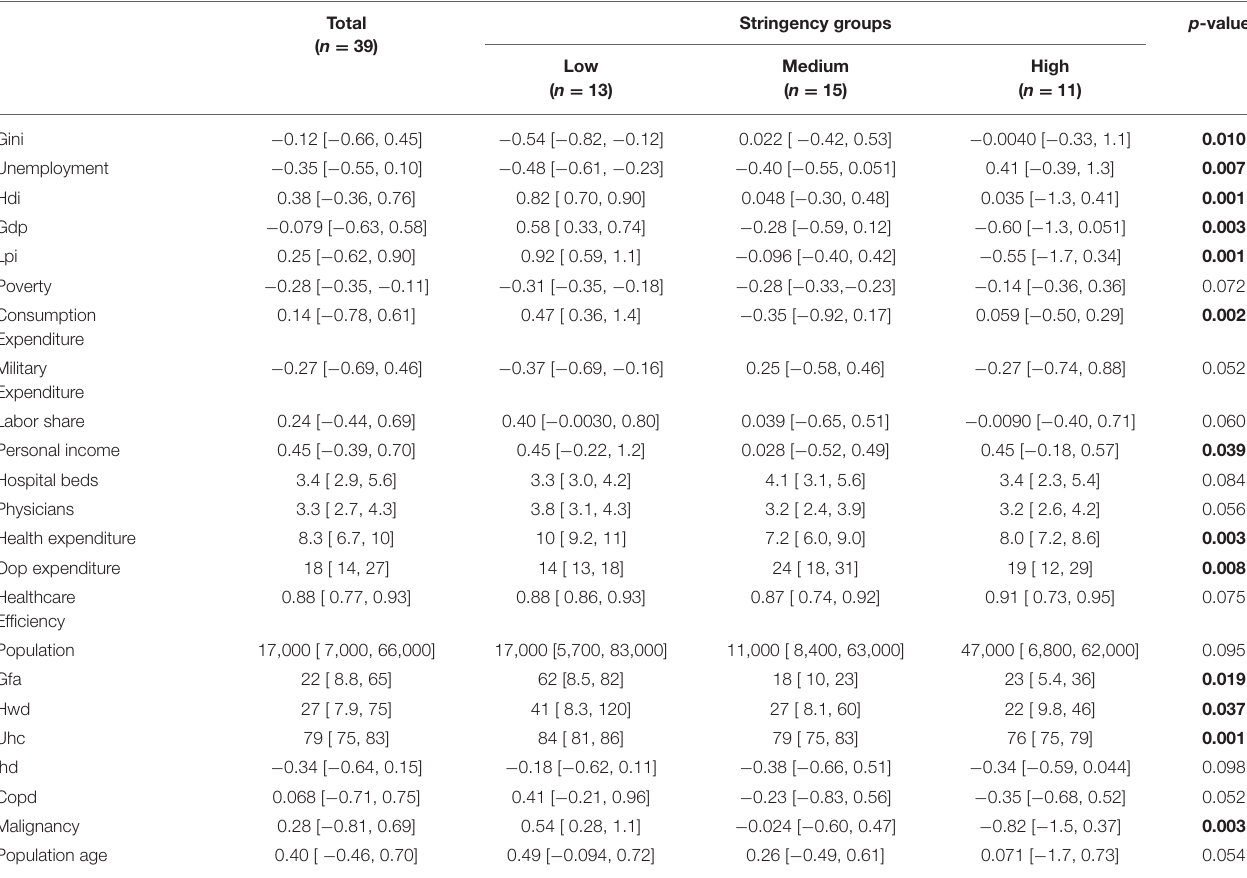
TABLE 2 | Statistical description of the variables for all countries according to the stringency group.